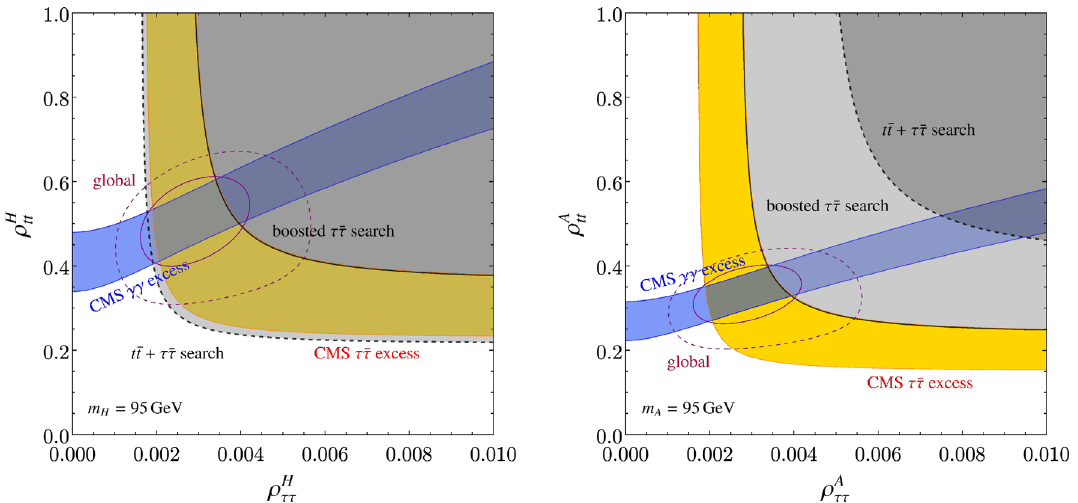
Fig. 3 The obtained ATLAS 95% CL limits are shown on a ρ ττ – ρ tt plane (see Table 1). The gray shaded regions surrounded by the solid and dashed lines are excluded by the ATLAS boosted τ ¯ τ and t ¯ t + τ ¯ τ searches,respectively.TheleftpanelisfortheCP-even( H )caseandthe limits from the data in the boosted τ ¯ τ and t ¯ t + τ ¯ τ searches by the gray shaded regions surrounded by the solid and dashed lines, respectively. The CP-even (odd) scalar with m H ( A ) = 95 GeV is considered in the left (right) panel. The CMS di-tau excess in Eq. (1) can be explained in the yellow region.